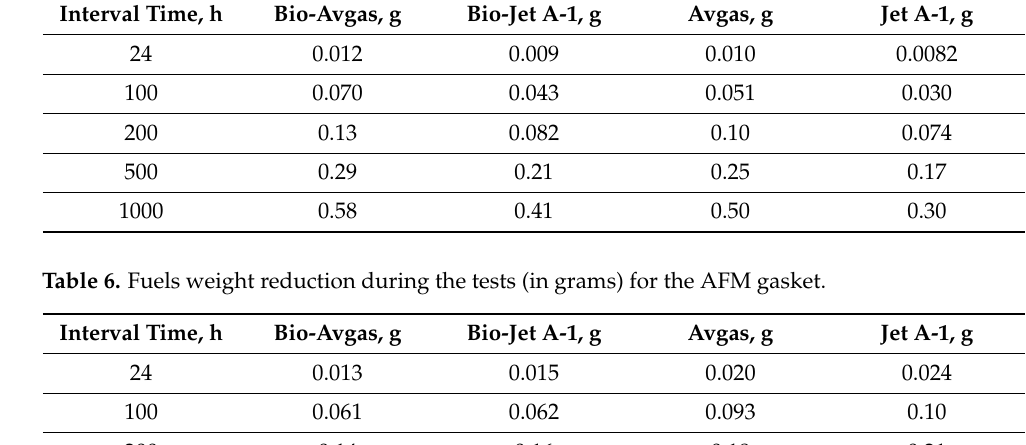
Figure 8. Time t 0 from when the secondary creep starts, which is marked on the contact pressure graph (red curve) for the AFM gasket and all the tested fuels. The blue line indicates the linear decrease of constant pressure.